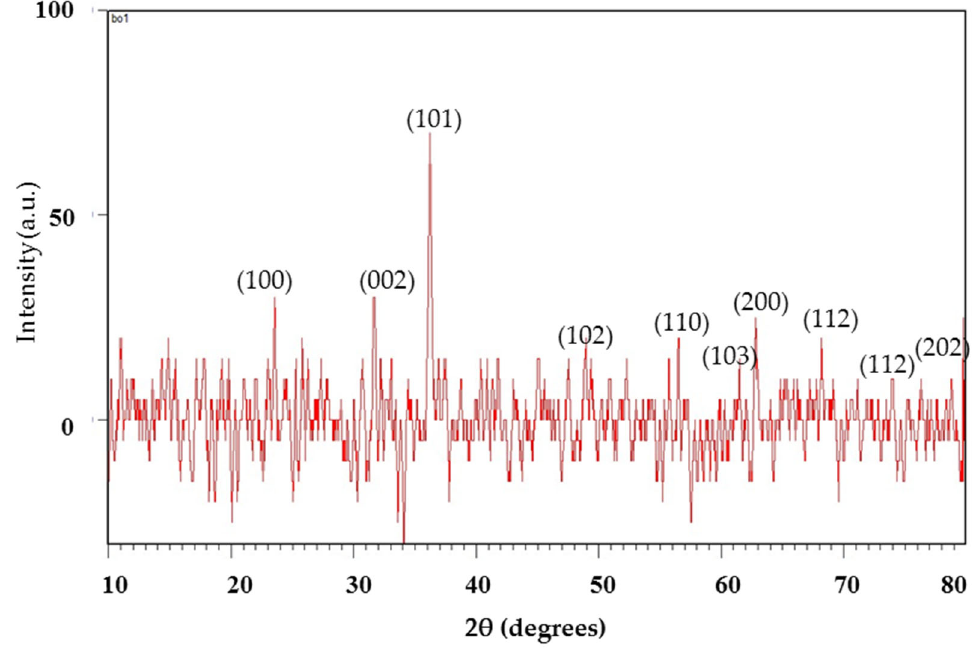
Figure 1. X ‐ ray diffraction pattern of the ZnO nanoparticles. Figure 1. X-ray diffraction pattern of the ZnO